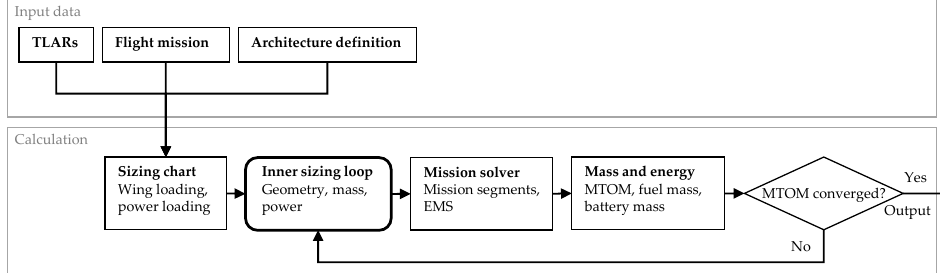
Figure 3. Schematic flowchart of the outer sizing loop.